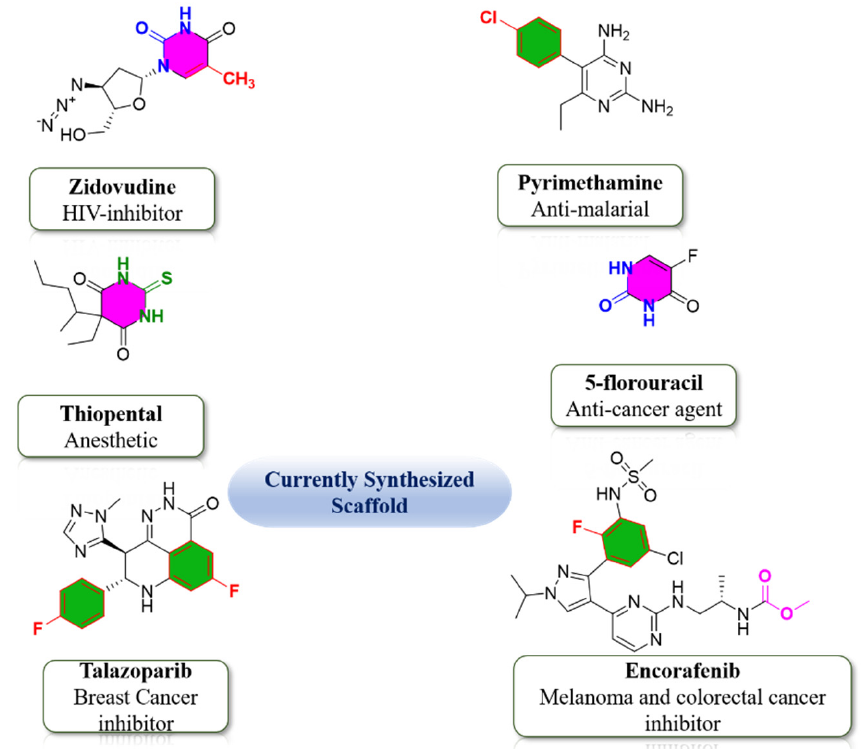
Figure 2. Biologically active functionality group-based currently synthesized Pyrimidine-scaffold.